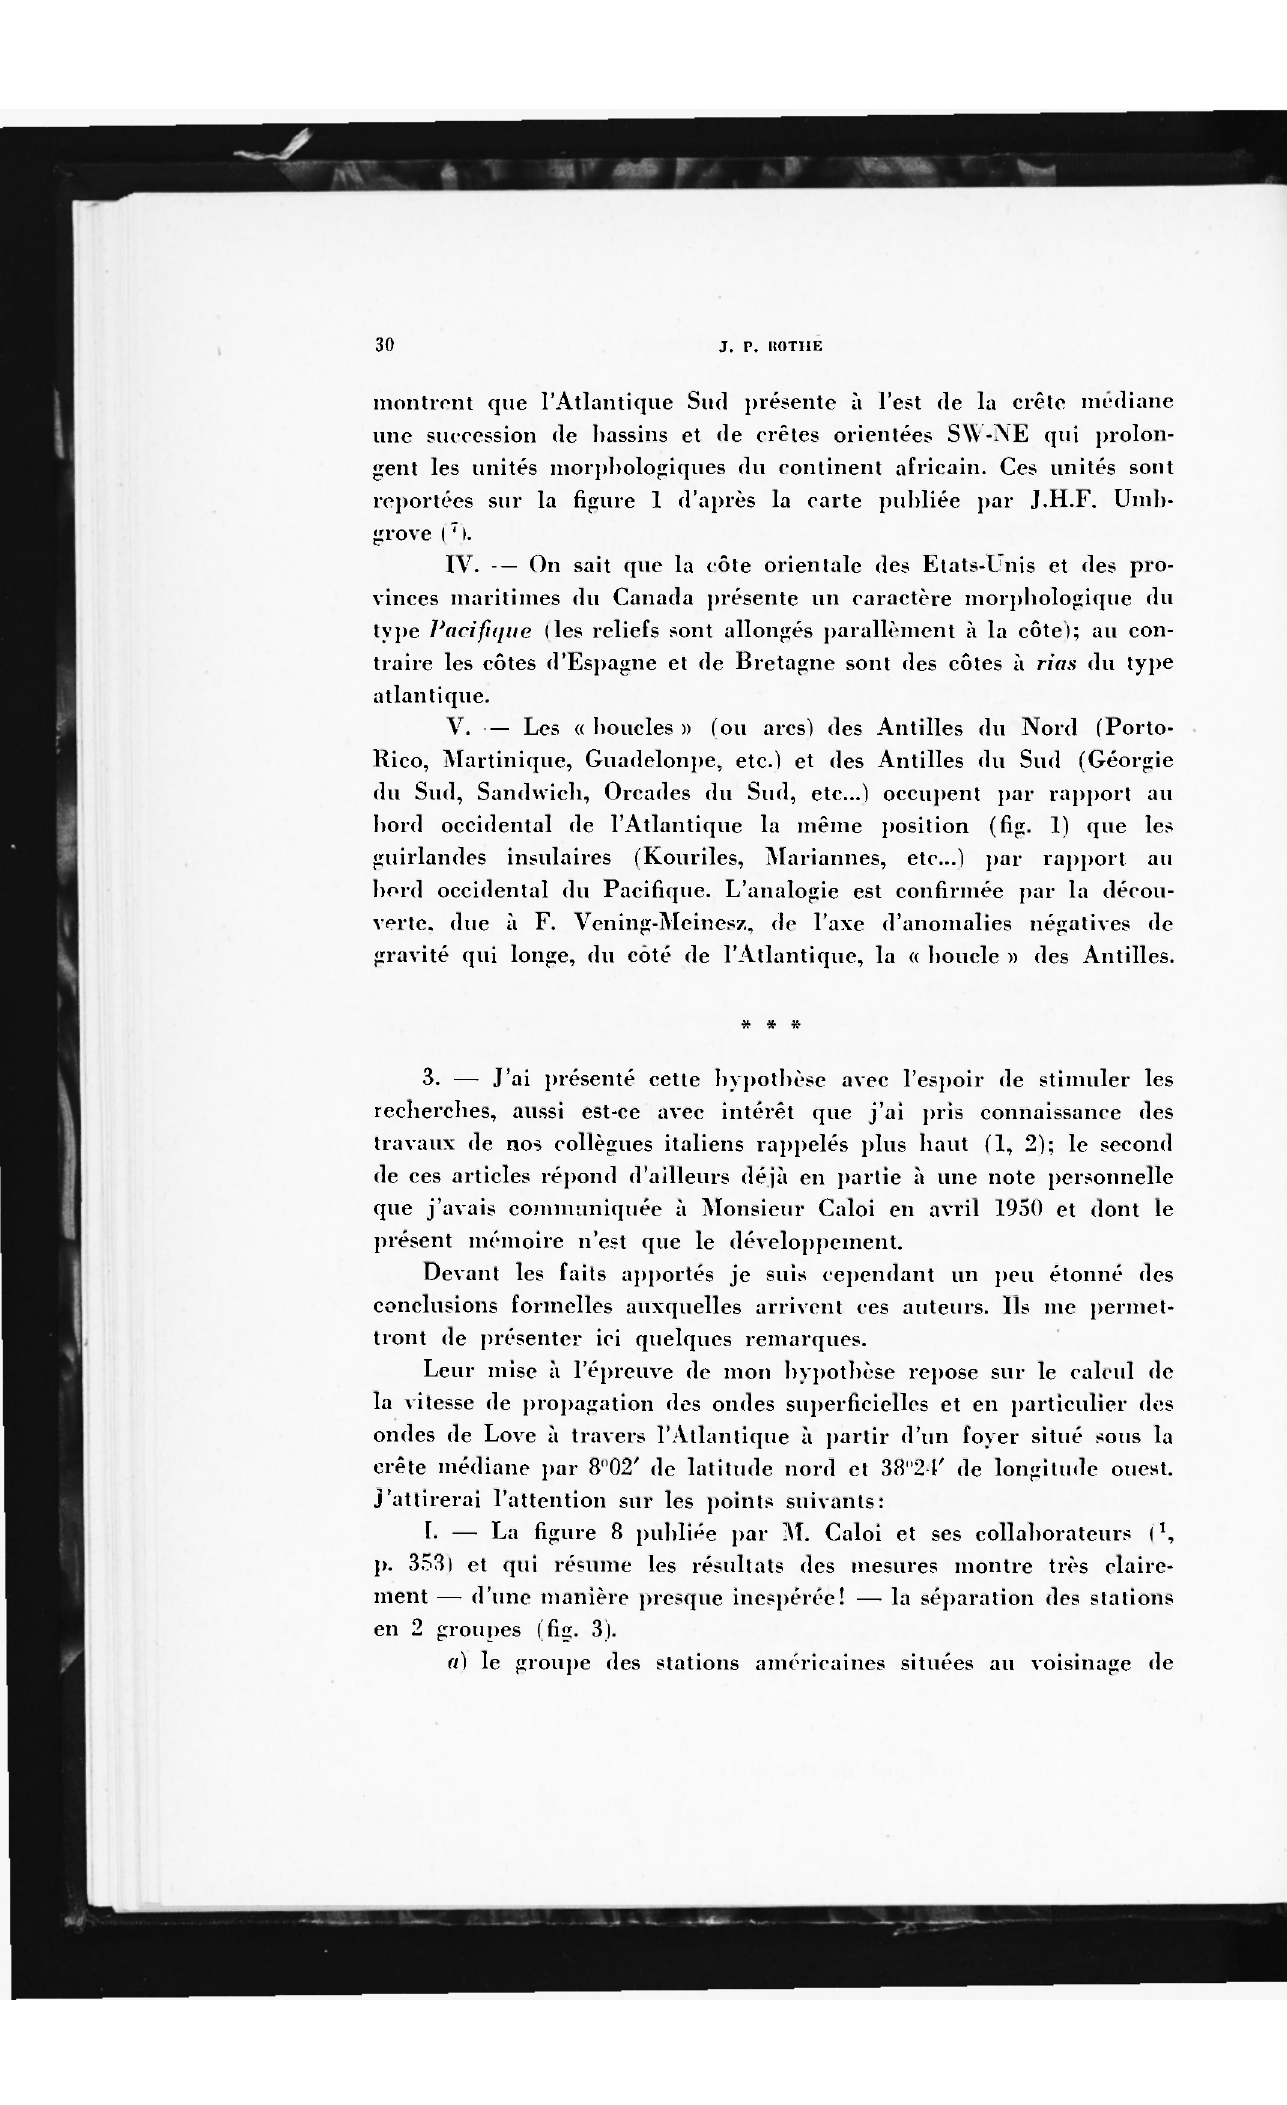
figure 8 publiée par INI. Caloi et ses